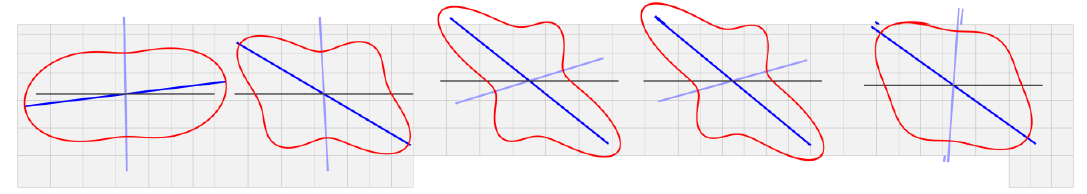
Figure 9. Optimized sti ff ness distribution ˆ E 11 ( θ ) for the η max objective model. Figure 9. Optimized stiffness distribution (cid:1831) (cid:3548) 11 ((cid:2016)) for the η max objective model. Figure 9. Optimized stiffness distribution (cid:1831) (cid:3548) 11 ((cid:2016)) for the η max objective model.